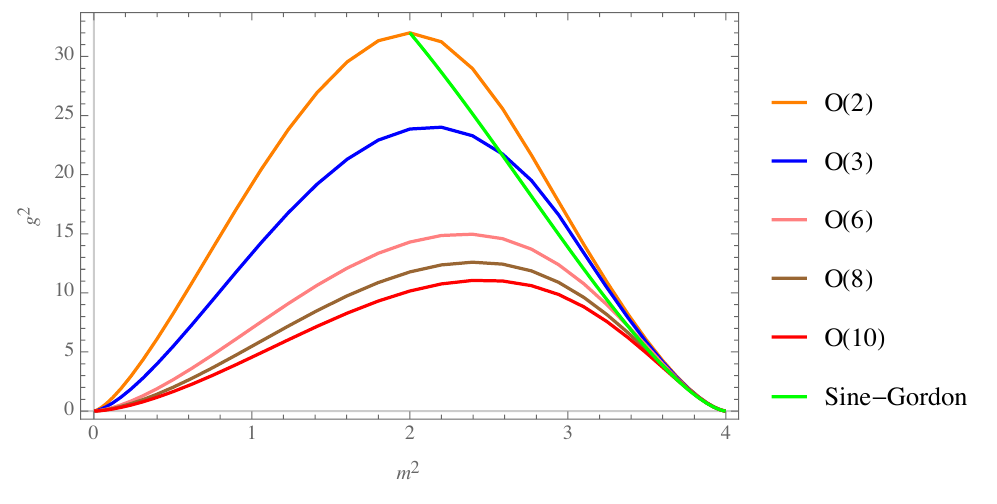
Figure 12 . Coupling bound when there is only one antisymmetric tensor(pseudoscalar for O(2) case). For comparison we also show the exact coupling constant for the sine-Gordon model with a single pseudoscalar, i.e. when (cid:24) > (cid:25)